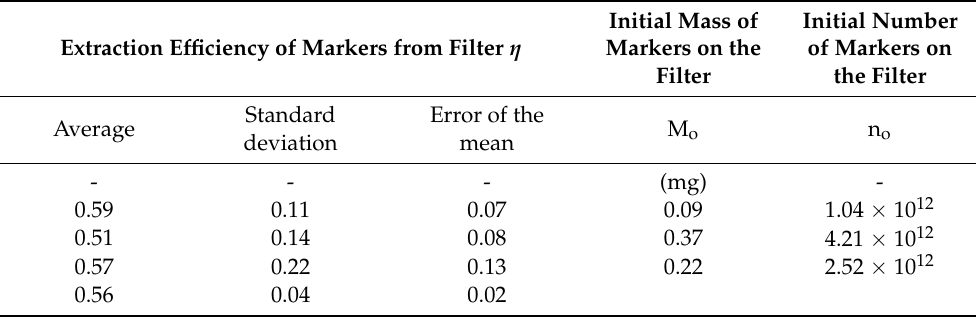
Table 6. Extraction efficiency of 40 nm markers taking into account the results of all subsequent